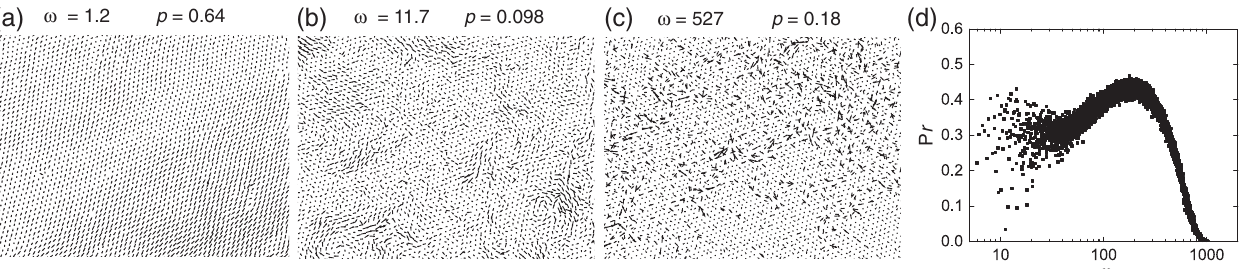
FIG. 2. Typical normal modes. (a) The nonlocalized plane wave with the lowest frequency ω . (b) A quasilocalized mode with a low ω and a low participation ratio p . (c) A mode with a high ω and low p . The polarization vectors in (a) – (c) show the vibration amplitude and direction of individual particles. (d) Participation ratios of all